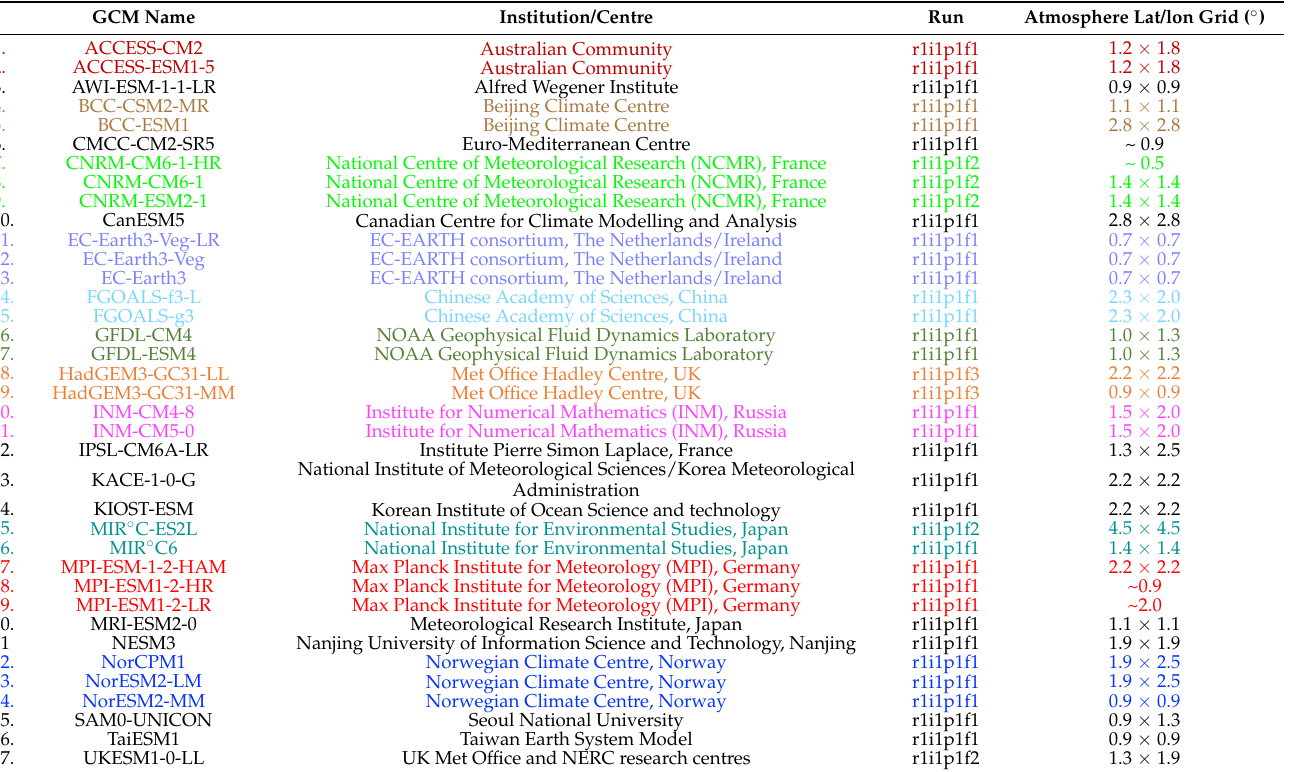
Table 1. CMIP6 Models and simulations used in this study. Here colours other than black denote GCMs from the same modelling